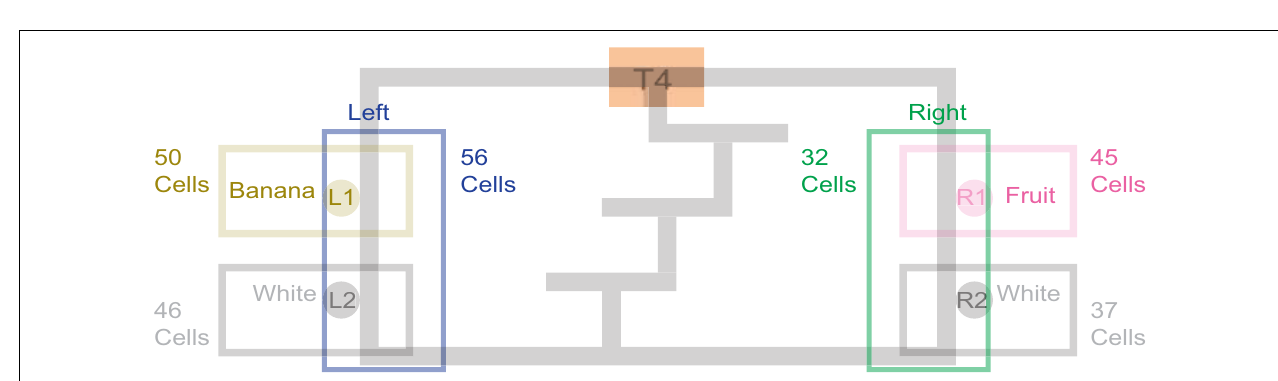
FIGURE 6 | Behavior on MT-LRA. (A) Rats performed at chance (dashed line) during the first few laps on the task.The rat had a 66% chance to receive food on his first lap because the first lap of an alternation session was always rewarded. As rats discovered the correctly rewarded contingency, their behavior stabilized and the majority of laps were correct (reward received). (B) Following the contingency switch, correct accuracy fell below chance (to the expected level the rat would show if it perseverated on the previous